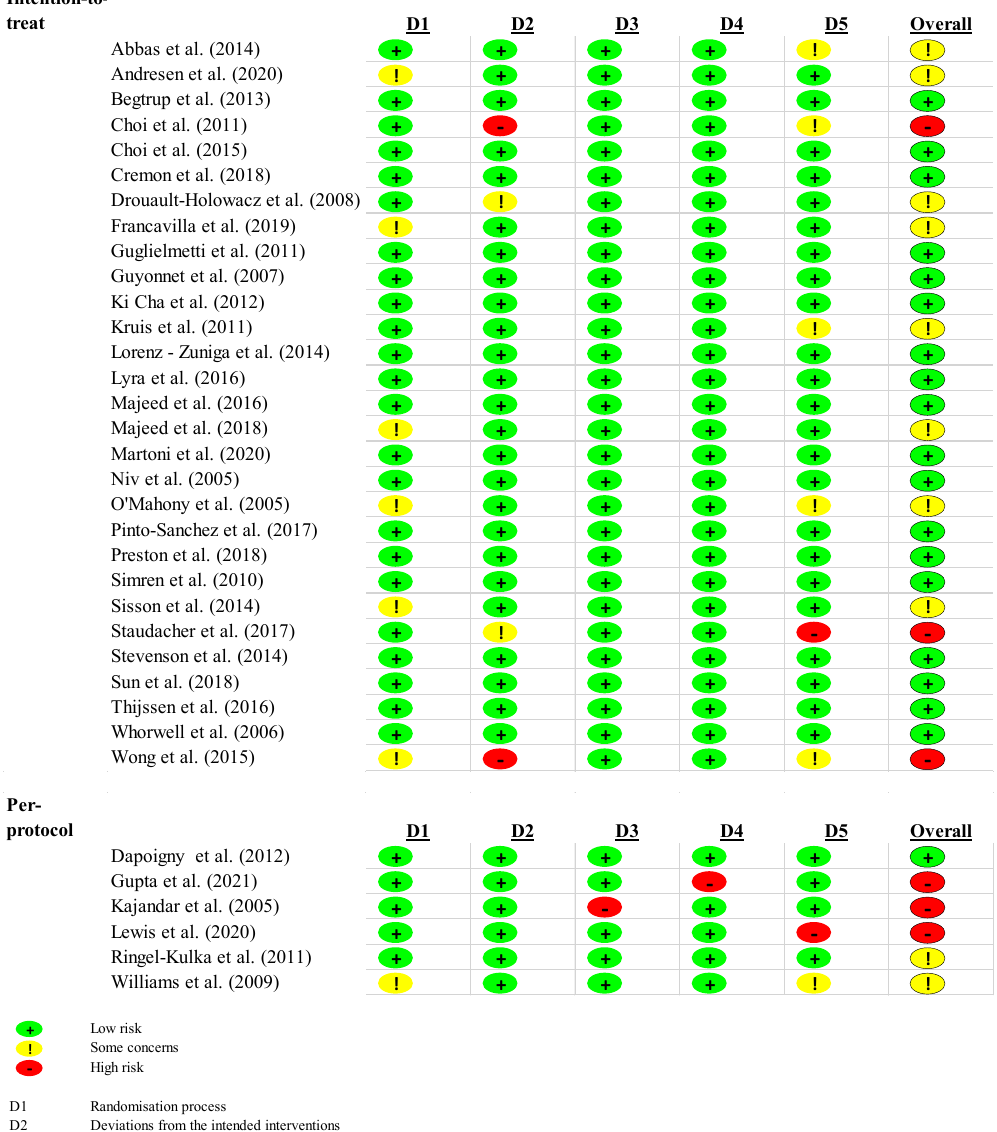
Figure 7. Risk of